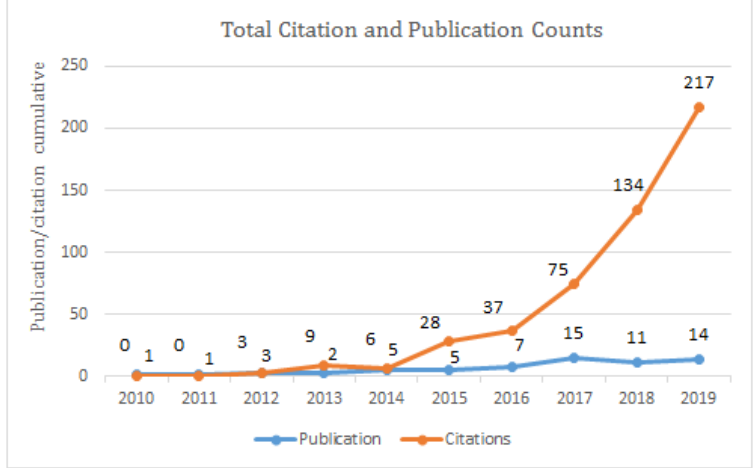
Figure 2. Total publication/citation counts per year